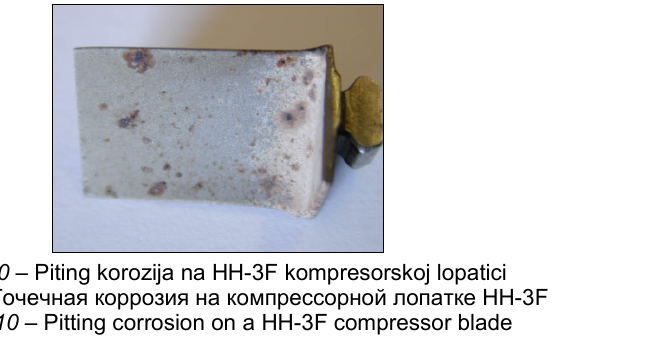
Figure 10 – Pitting corrosion on a HH-3F compressor